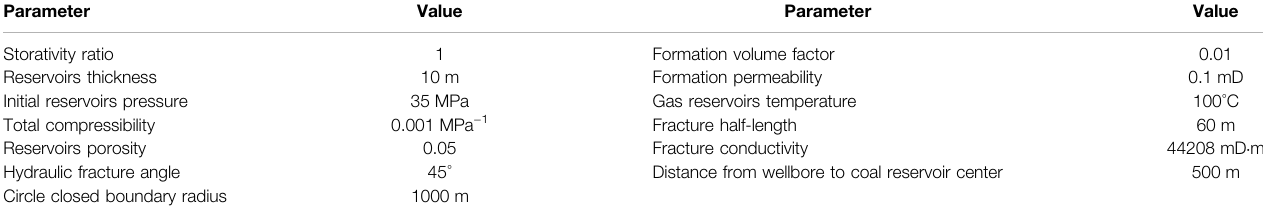
TABLE 2 | Model veri fi cation basic parameter.